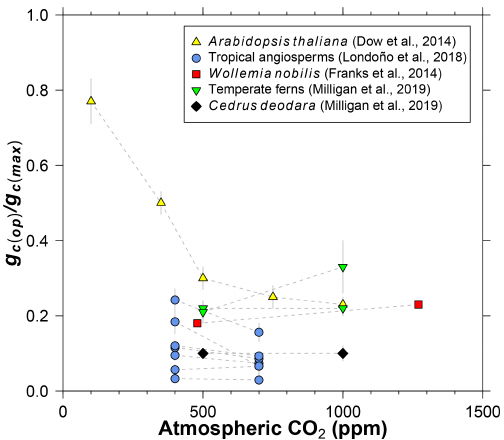
Figure 3. Literature compilation of the sensitivity of g c(op) /g c(max) (ratio of operational to maximum leaf conductance to CO 2 ) to at- mospheric CO 2 concentration.